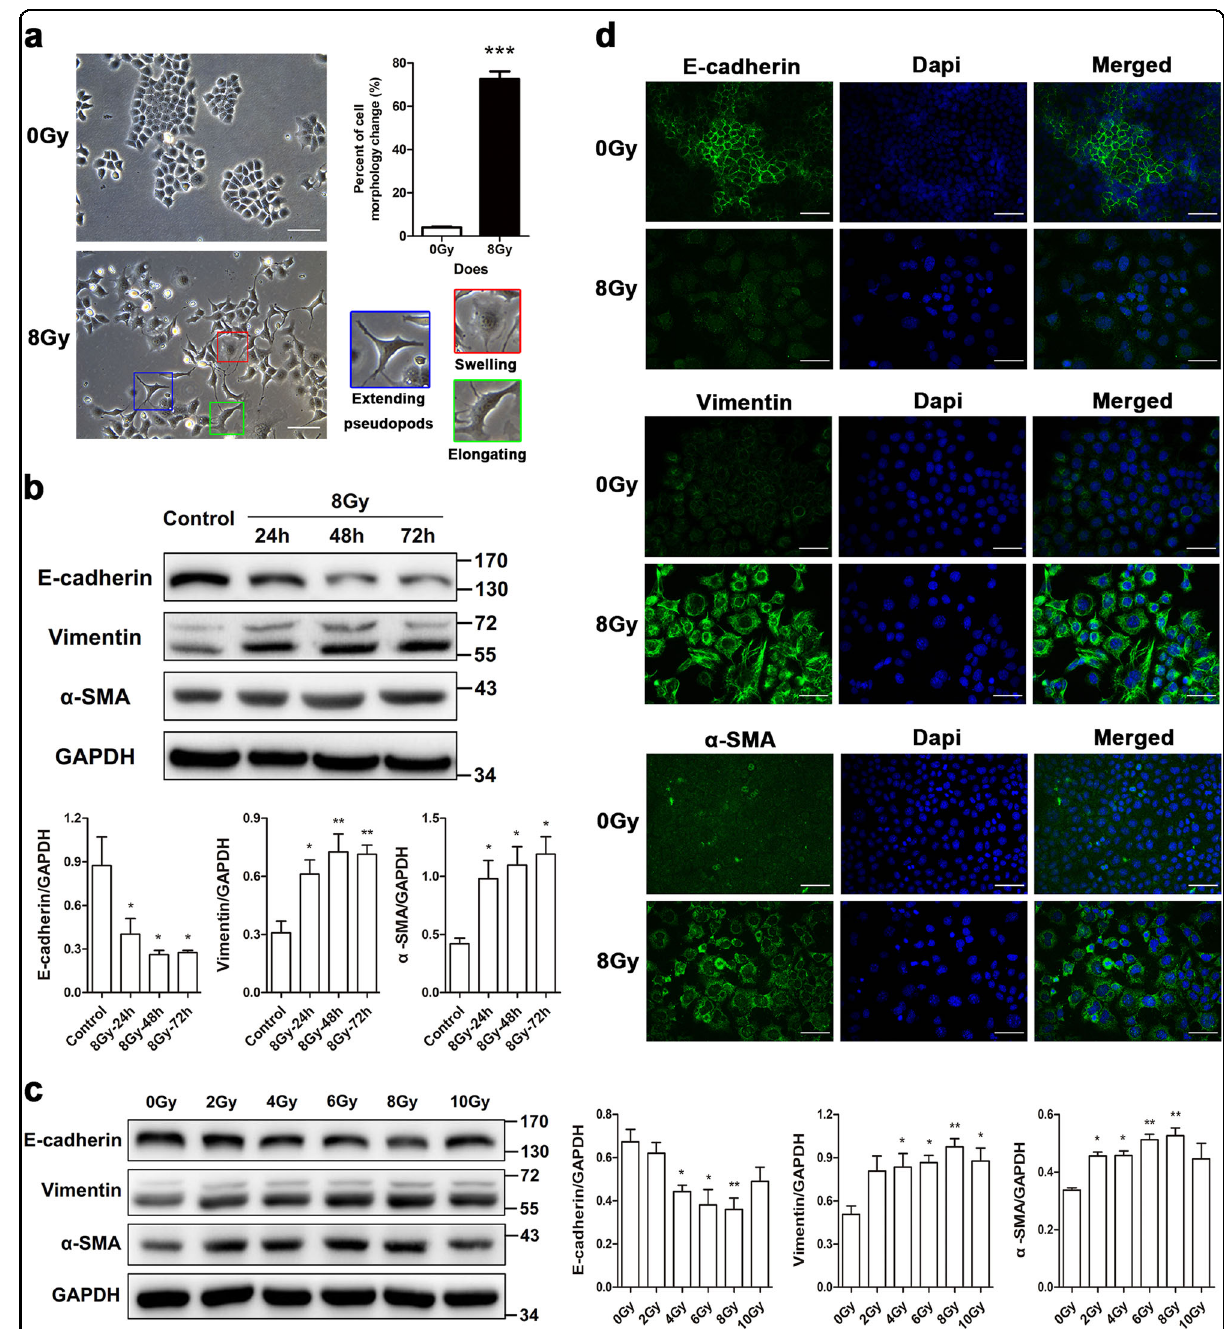
Fig. 1 Radiation induces changes in cell morphology and EMT-associated protein expression in RLE-6TN cells. Cells were irradiated with a single dose of 2, 4, 6, 8, or 10 Gy 60 Co γ -rays, and cell morphology and EMT-associated protein markers were observed at 24, 48, and 72 h postirradiation. a Representative images of cell morphology (photographed at 48 h after 8 Gy irradiation or nonirradiation). Cells suffering morphologic changes were counted in random microscope fi elds according to whether cells became swollen (red outline), elongated (green outline), or exhibited extended pseudopodia (blue outline) compared with a cuboidal appearance, and the percentage was calculated. Scale bar represents 100 μ m. The data are presented as the mean ± SEM ( n = 10). *** P < 0.0001 vs. nonirradiated control. b , c Representative western blots and densitometric quanti fi cation of E-cadherin, vimentin, and α -SMA protein levels. GAPDH was used as the loading control. The data are presented as the mean ± SEM ( n = 3). * P < 0.05 and ** P < 0.01 vs. nonirradiated control. d Immuno fl uorescence staining for E-cadherin, vimentin, α -SMA (green), and DAPI (blue) in nonirradiated control and irradiated cells at 48 h postirradiation. Scale bar represents 50 μ